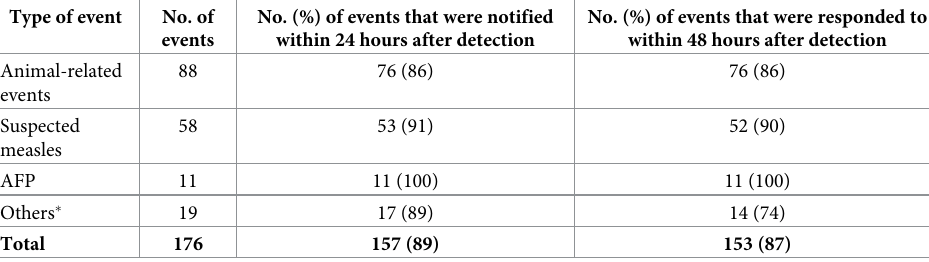
Table 3. Time from community-level detection to district-level notification and response initiation of events reported from September 2018–March 2019 (N = 176). Type of event